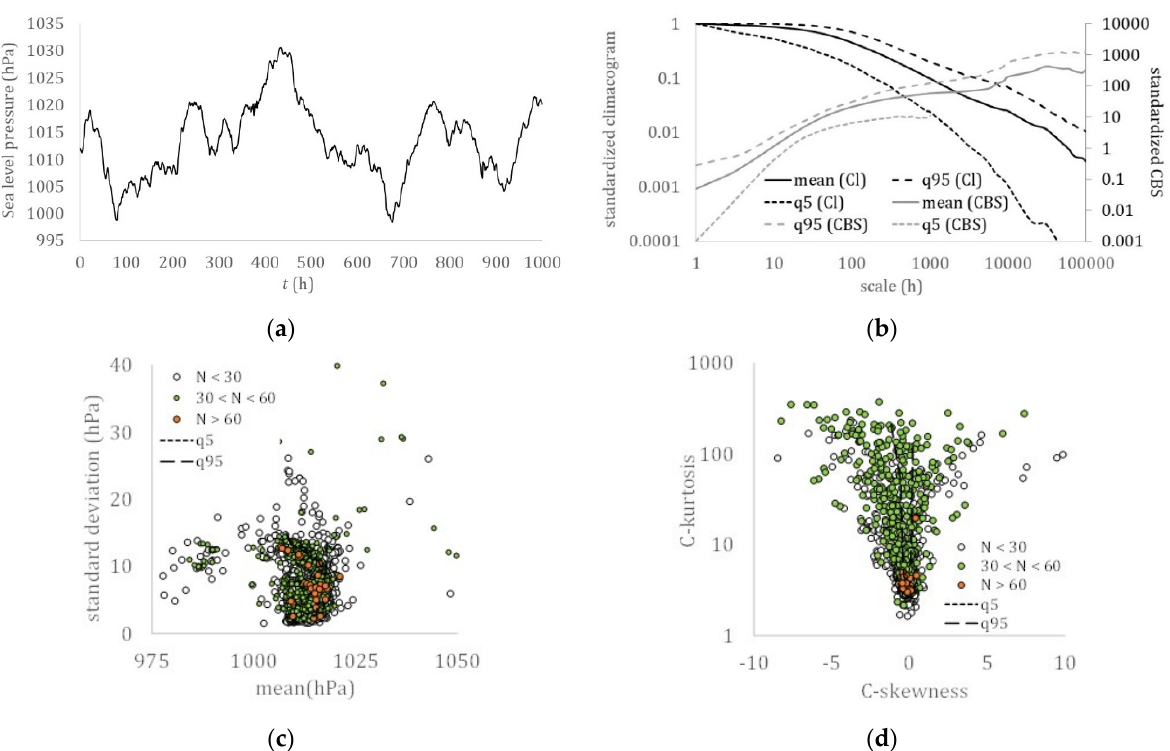
Figure 5. Sea level pressure: ( a ) hourly sample (Boston, USA); ( b ) climacogram and climacospectrum (mean, and 5% and 95% quantiles); ( c ) mean vs. standard deviation; ( d ) C-skewness vs. C-kurtosis.